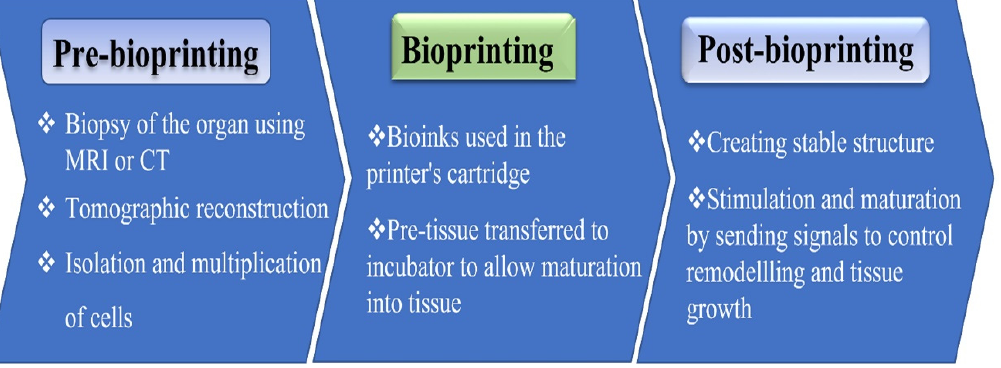
Figure 1. Vital steps of bioprinting: From pre- to